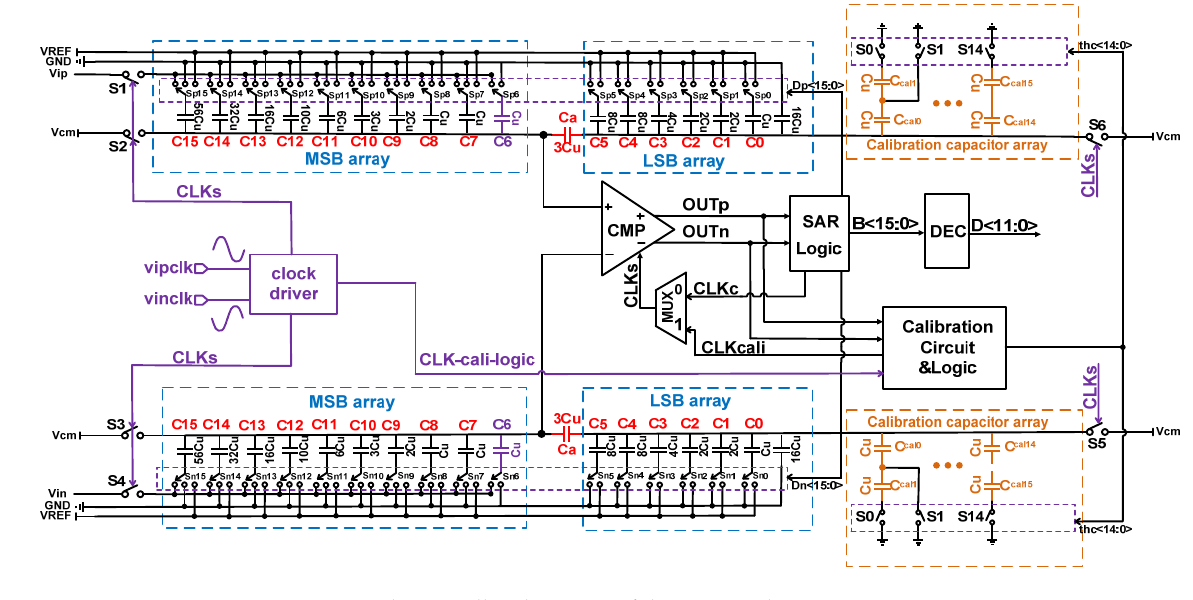
Figure 1. The overall architecture of the proposed SAR ADC.